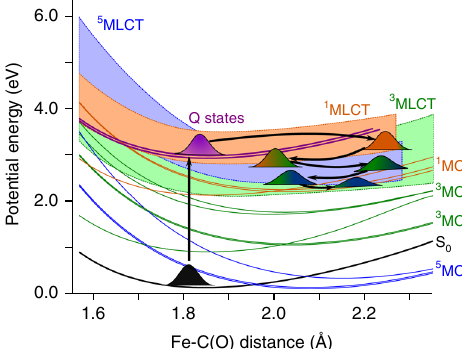
Fig. 2 Potential energy surface along a dissociative mode. Plot of the potential energy surfaces along the Fe – C(O) distance. The LS state S 0 , and the 1 Q states are shown in black and magenta, respectively. The singlet manifold is shown in orange, the triplet manifold in green and the quintet manifold in blue. The metal-centered (MC) states are shown explicitly, whereas the metal-to-ligand charge transfer (MLCT) states are depicted as a quasi-continuous band. Further, a schematic evolution of the wavepacket dynamics is shown. After absorption to the Q-band, the wavepacket undergoes large-amplitude oscillations in the Fe – CO coordinate on the 1 MLCT state. Then, it cascades down acquiring more 3 MLCT and 5 MLCT character as the spin crossover transitions occur. Finally, the wavepacket disperses, and the Fe – C(O) distance oscillations decrease to a value of 2.2